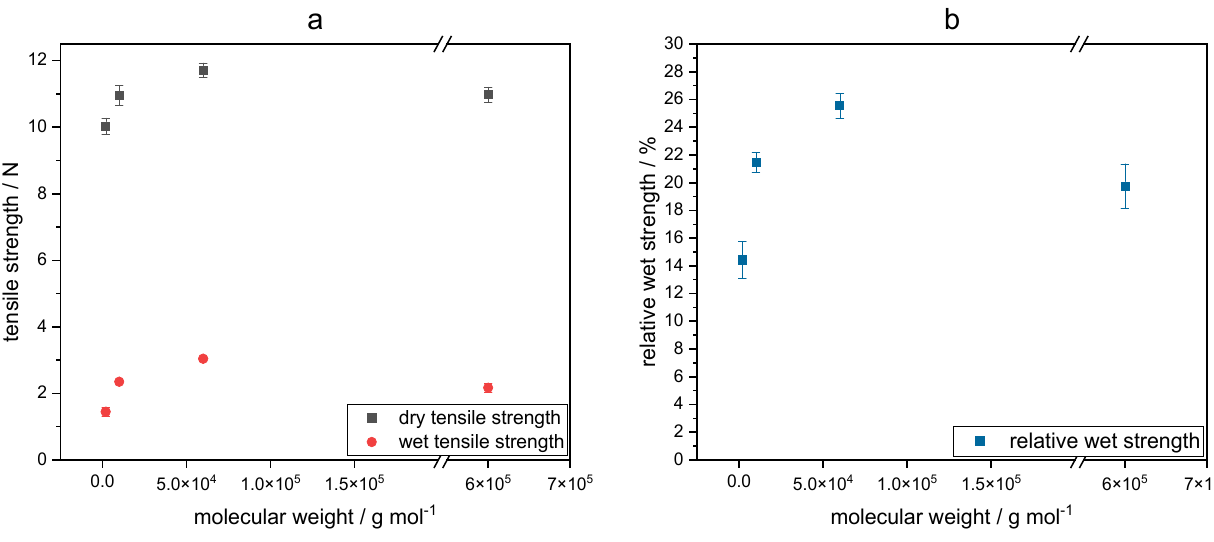
Figure 9. Influence of undegraded keto-HPC cross-linked with PEI with different molecular weights on the dry and wet tensile strength ( a ) and relative wet strength ( b ) in paper. The coating weight of keto-HPC + PEI is 1.5 wt% related to dry fibers. Note that the degree of branching of these investigated PEIs remains the same but polydispersity differs [43].